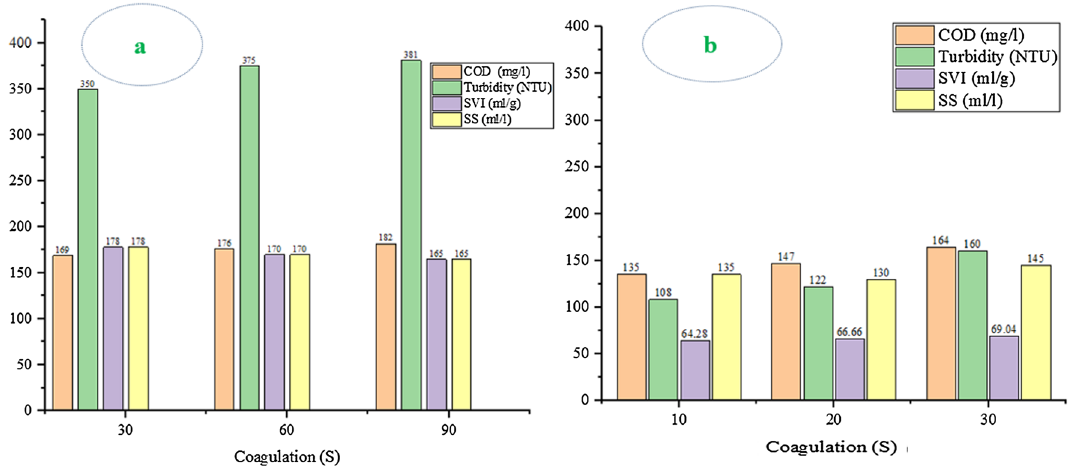
Fig. 2 Effect of coagulation time on COD, turbidity, SVI, and SS. b non-ozonation a ozonation = 15 min. (polymer concentration = 30 gr/dry SL,